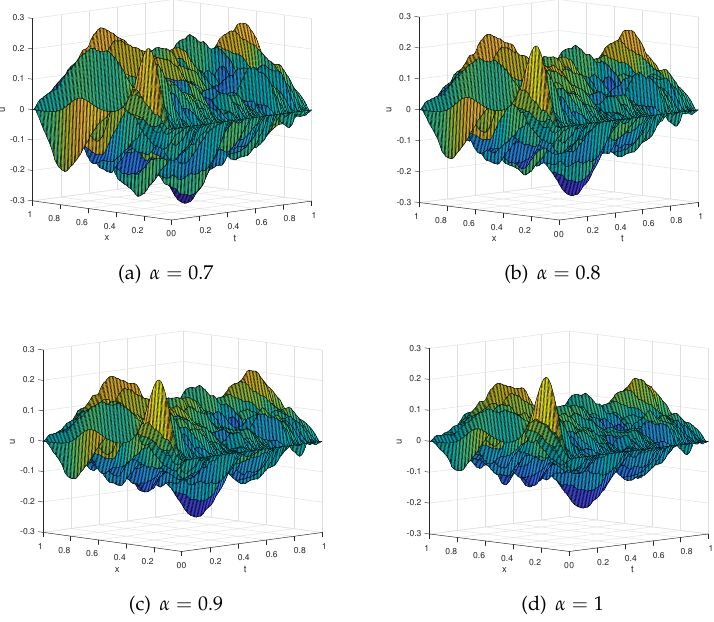
Figure 5. The approximation solutions of Example 2 (case (1)) with σ =